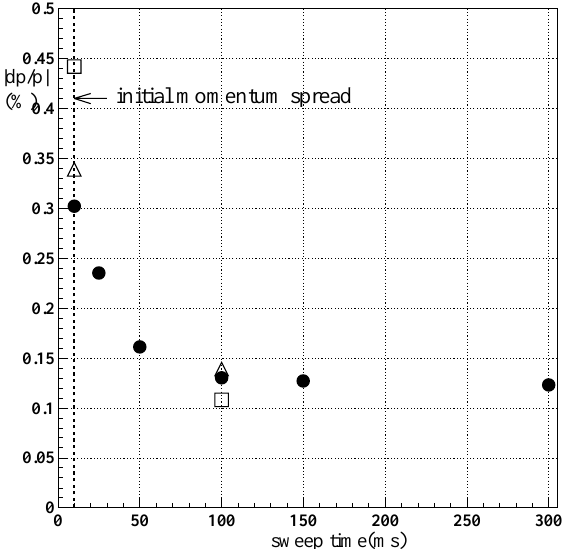
FIG. 8. Momentum spread against the sweep time. The markers on the dotted line show their initial dp (cid:1) p . The different markers show the different initial dp (cid:1) p . The initial dp (cid:1) p of the black circle is 0.003. Those of the white triangle and square are 0.0034 and 0.0044, respectively. The beam intensity was about 7 3 10 12 protons (cid:1)